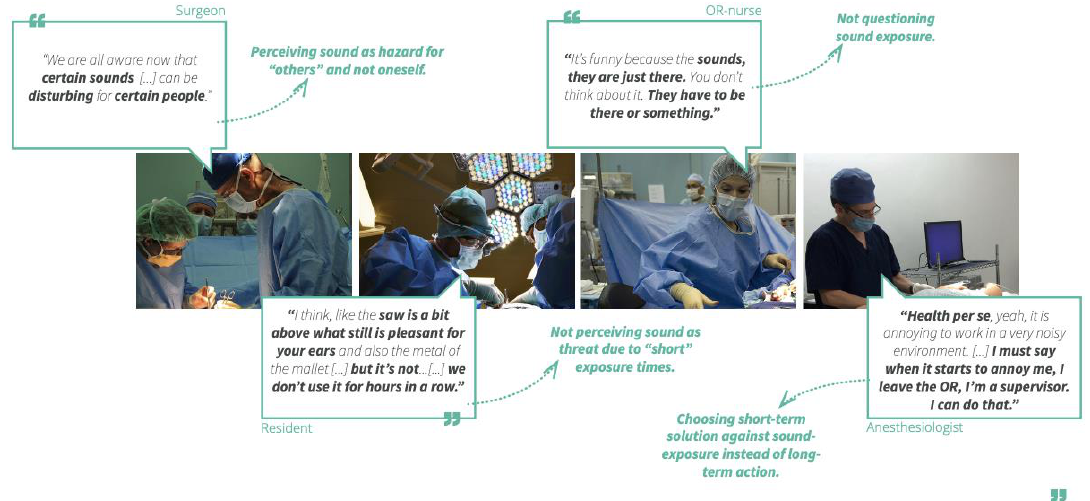
Figure 11. Quotes of medical staff, including the researchers’ interpretation. Photos (retrieved freely from Pixabay) in this artistic representation do not belong to our study.